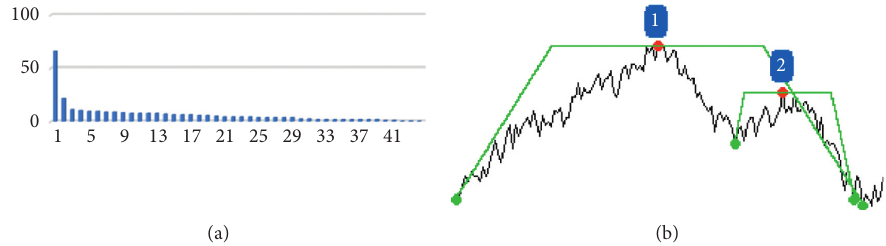
Figure 12: (a) Sorted prominences of Road4 data, where the ratio of the second (the prominence of the last detected peak) to the third (the greatest prominence of the noise) is 194%. (b) The detected peak points (each marked by its prominence ordinal number) and the supporting hills.